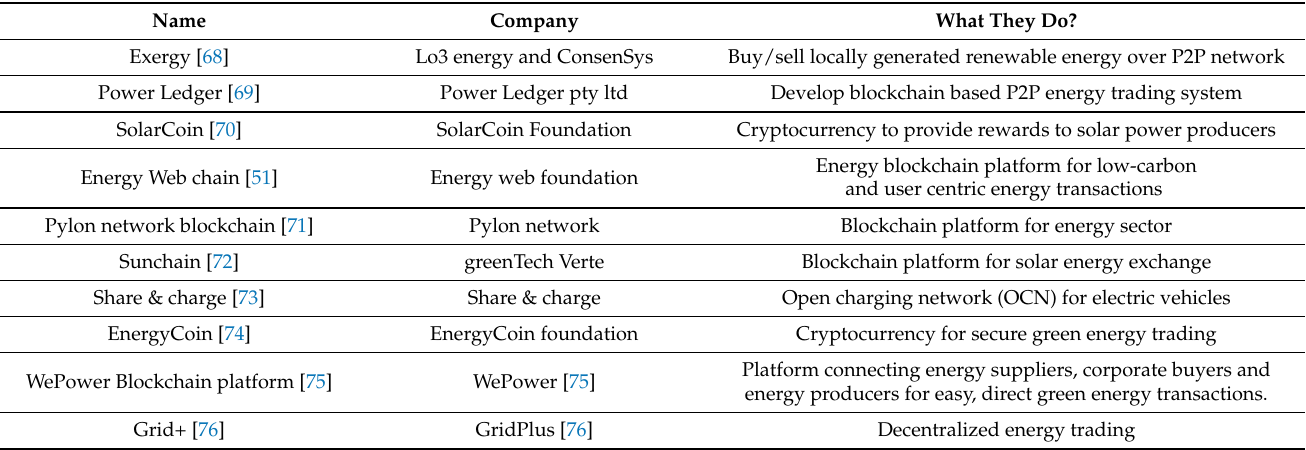
Table 4. Different energy and blockchain